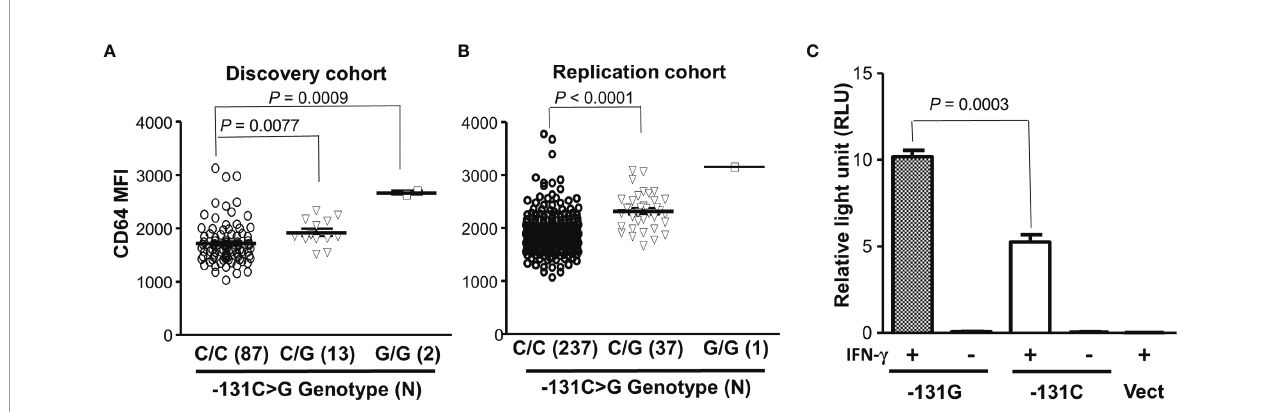
FIGURE 2 | Effect of the SNV rs1848781 (c.-131C>G) on CD64 expressions. (A) Monocytes from SNV rs1848781 -131G/G homozygous donors expressed signi fi cantly higher levels of CD64 than those from -131C/C homozygous donors (Mann-Whitney test, P = 0.0009). Monocytes from -131C/G heterozygous donors also expressed signi fi cantly higher levels of CD64 than those from -131C/C homozygous donors ( P = 0.0077). (B) The phenotype/genotype analysis of CD64 expressions in FCGR1A genotyped donors was con fi rmed with a replication cohort. (C) The promoter reporter construct containing -131G allele had signi fi